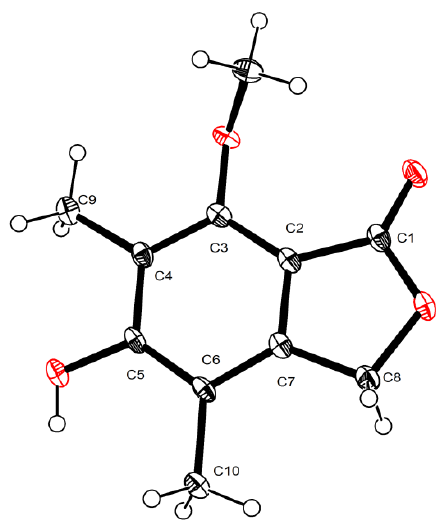
Figure 5. ORTEP drawing of the X-ray structures of 4 .